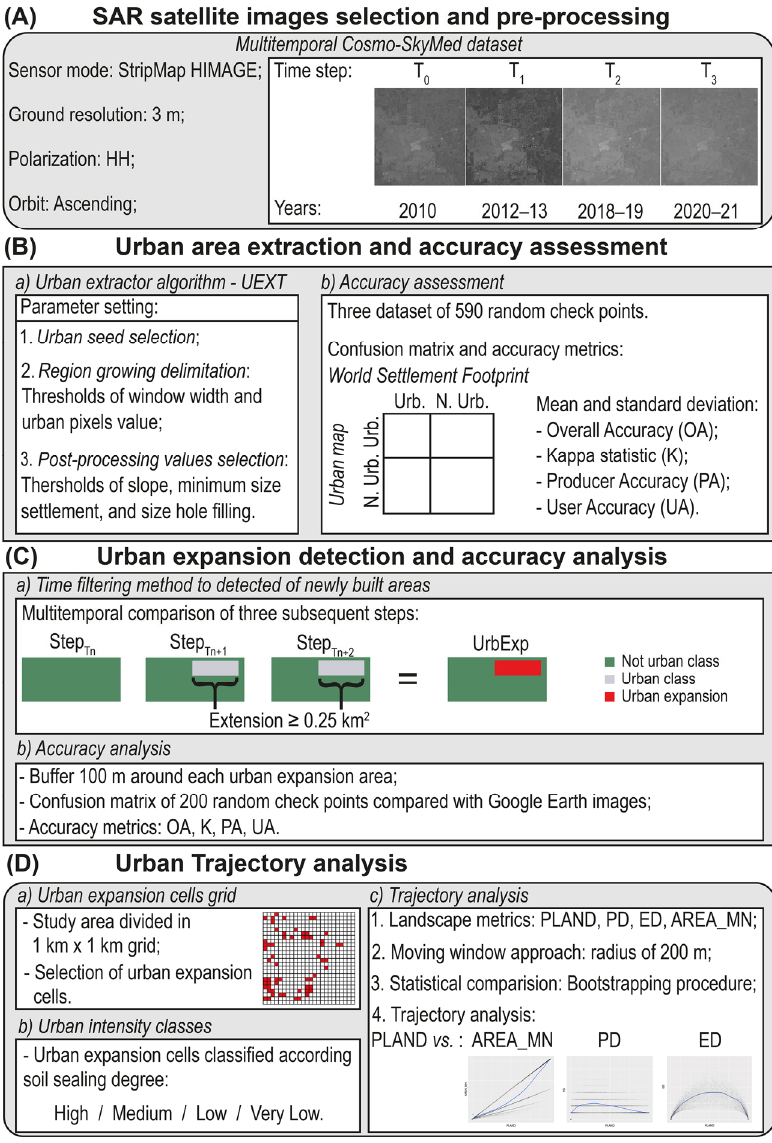
Figure 2. Workflow describing the procedure followed to extract from SAR data the urban area extents over time, to detect urban changes, and to describe landscape composition and configuration over the last decade in the metropolitan area of Cordoba.